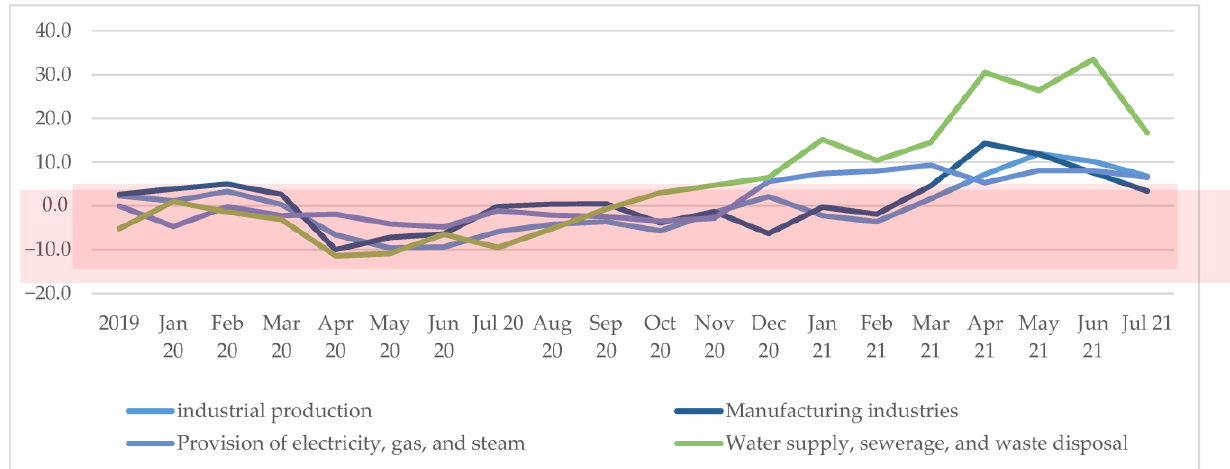
Figure 1. Dynamics of production in the main sectors of the Russian economy, %. Source: compiled by the authors.